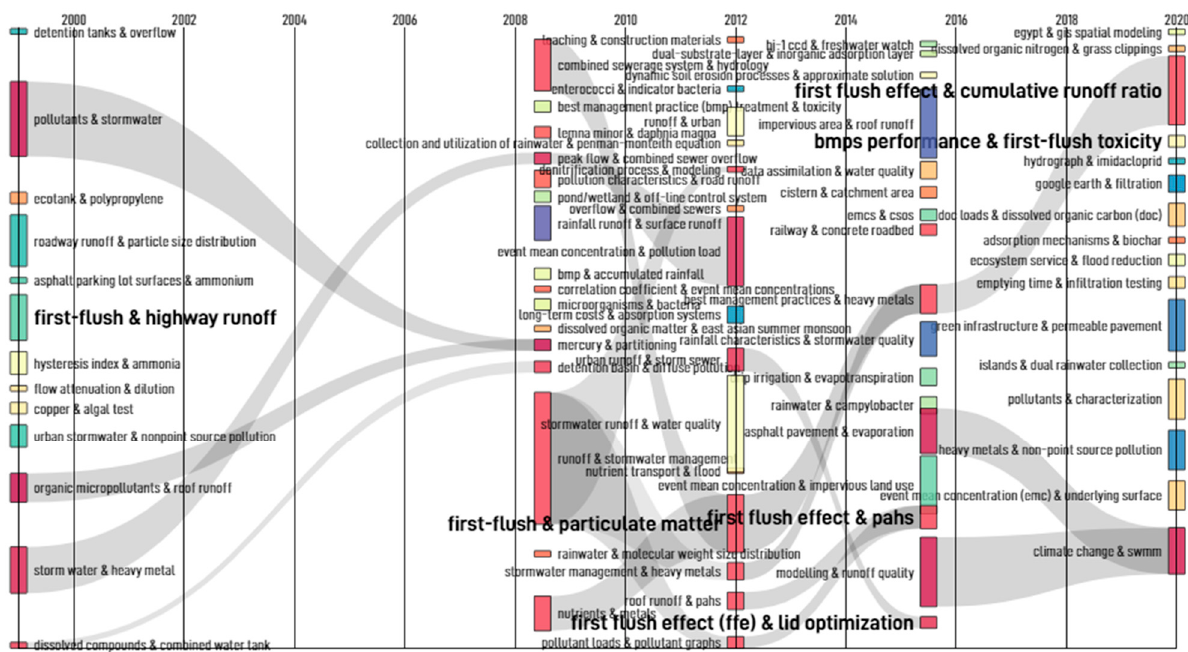
Figure 4. The Sankey Diagram for keywords “first flush” and “stormwater” or “storm water” or “runoff” and “urban” based on the Scopus database.